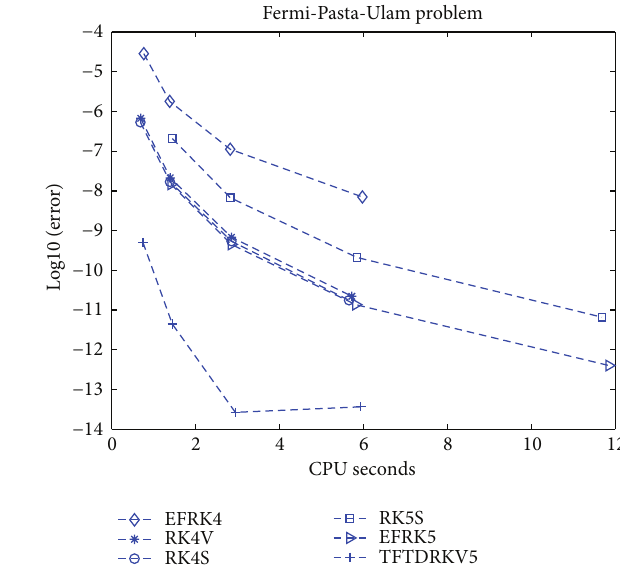
Figure 8: Efficiency curves for Problem 4.